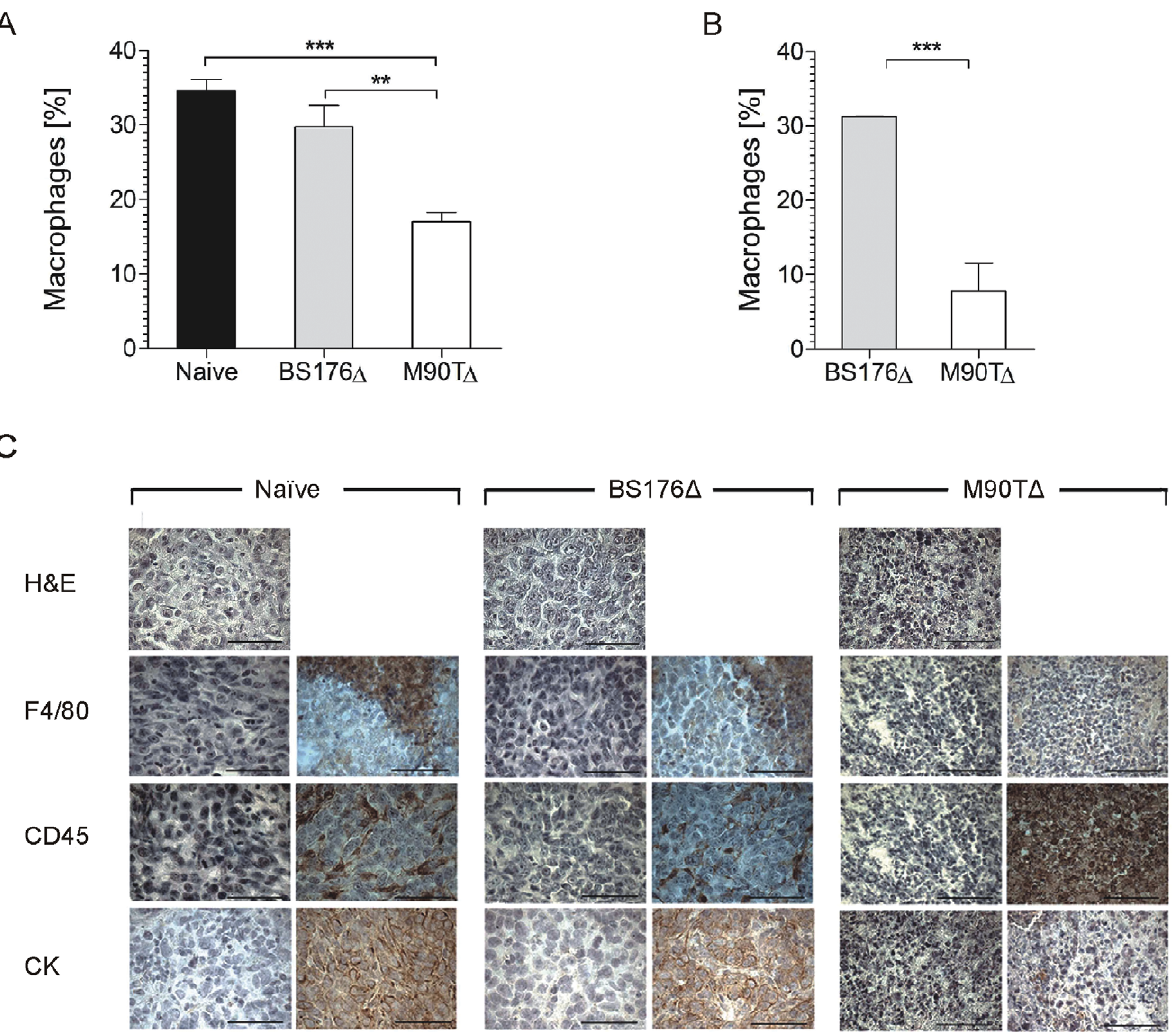
Figure 4. Infection with Shigellaflexneri M90T D aroA results in a decrease in TAMs number. 7d after IV infection of tumor bearing Balb/c (A) and MMTV-HER2 FVB mice (B) tumors were analysed for F4/80 positive cells by FACS to determine the relative amount of TAMs. Bars represent means + / 2 SD of four tumors analyzed per group, ** P , 0.01, *** P , 0.001. (C) Histology of tumor tissue from non-infected, BS176 D - or M90T D - infected mice. In each case left panels represent antibody controls. Scale bars represent 50 m m. BS176 D : Shigella flexneri BS176 D aroA ; M90T D : Shigella flexneri M90T D aroA ; CK: Cytokeratin.